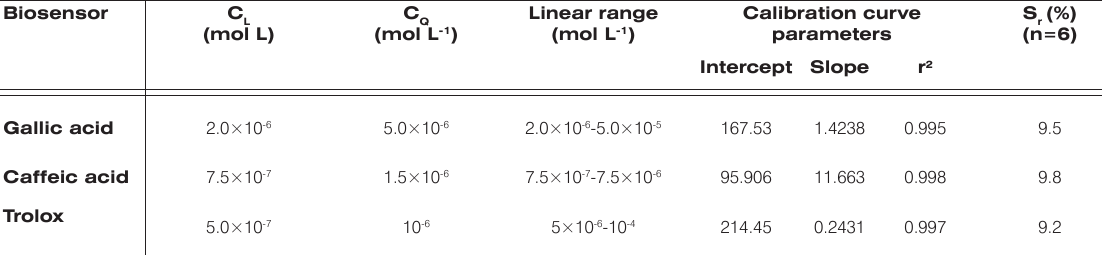
Table 2. The analytical performance of the biosensor with the studied phenolic acids.